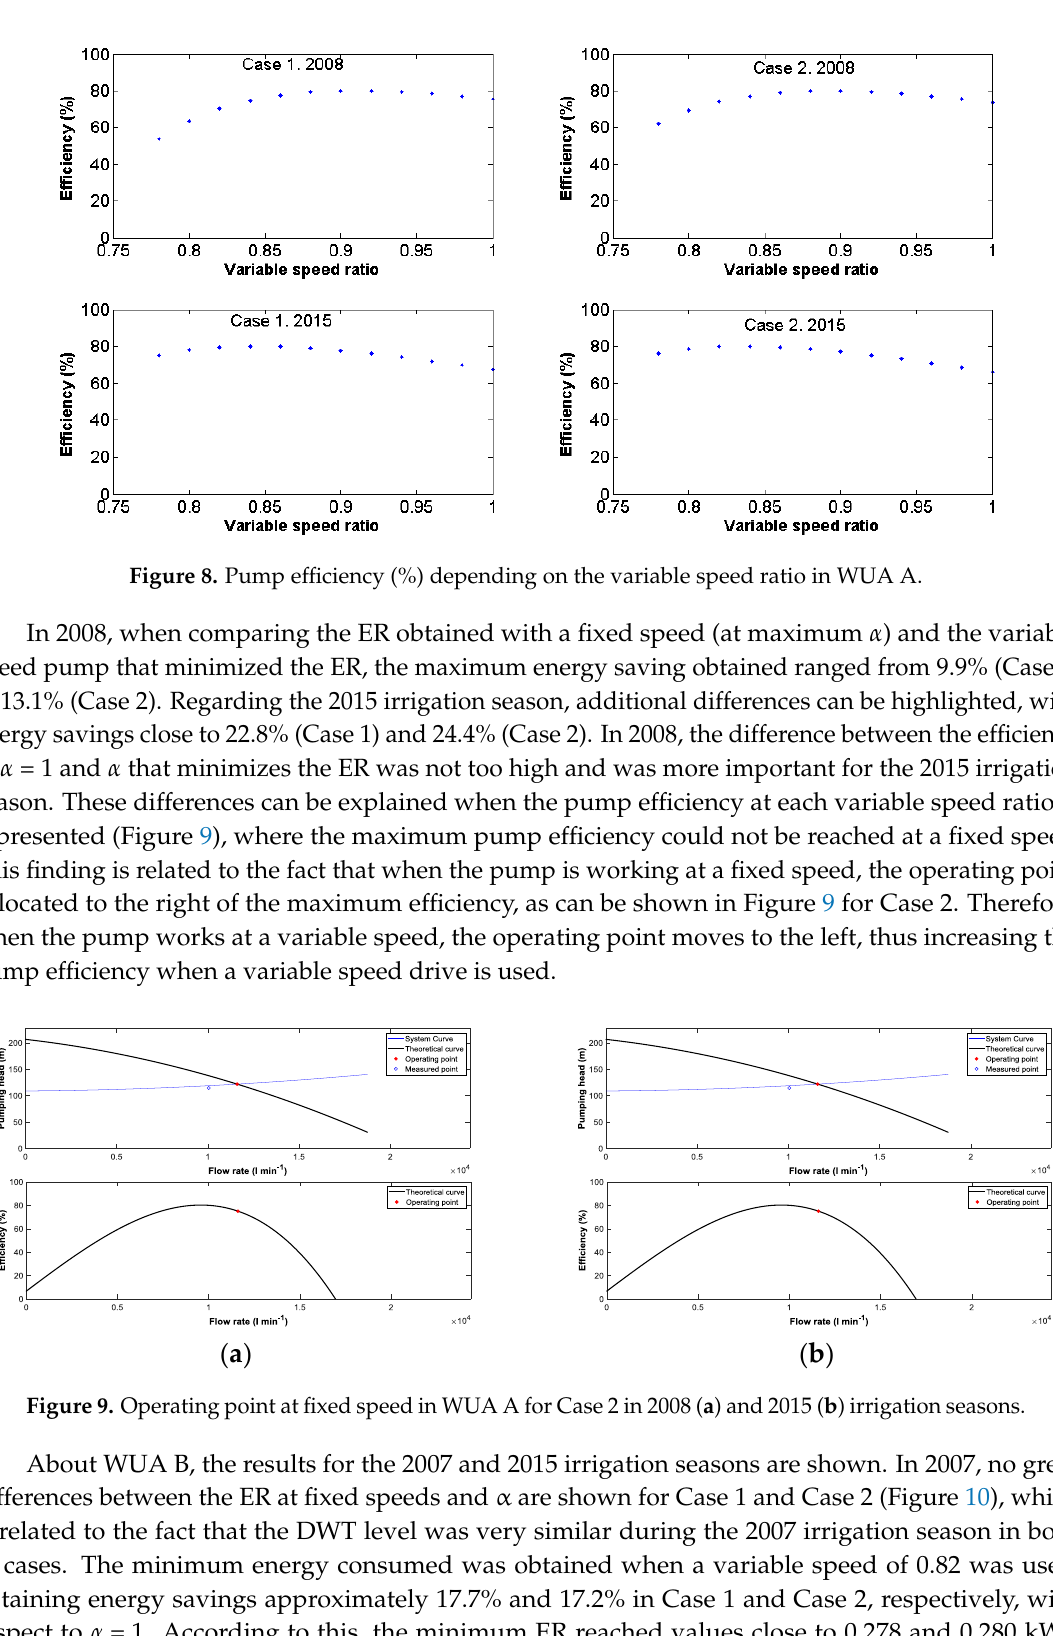
Figure 7. Energy ratio (kWh m −3 ) at each variable speed ratio ( α) in WUA A.